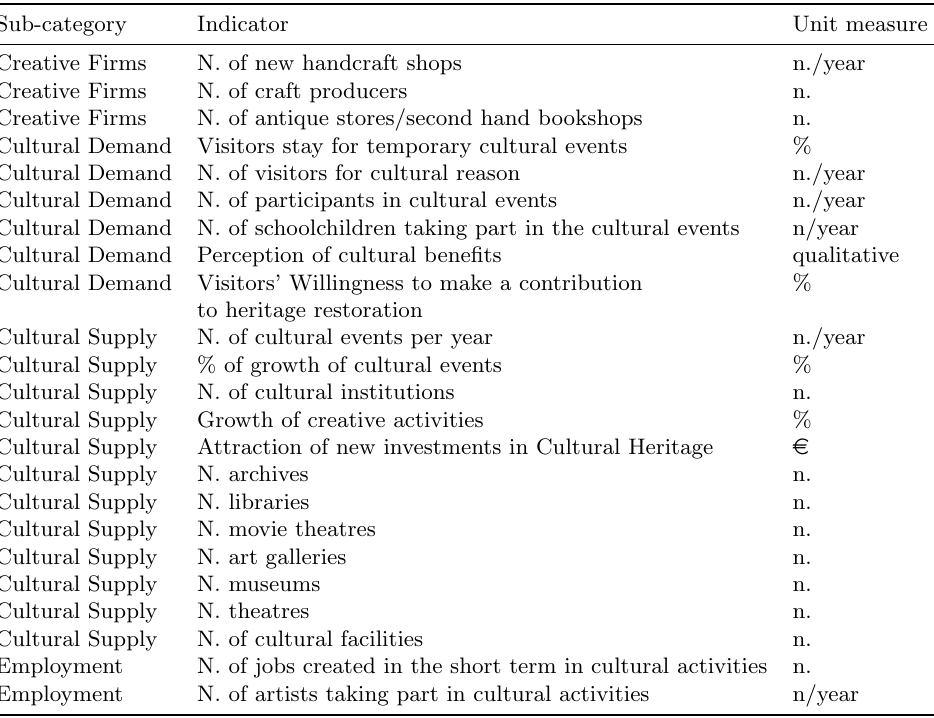
Table 2: Creative and cultural activities indicators